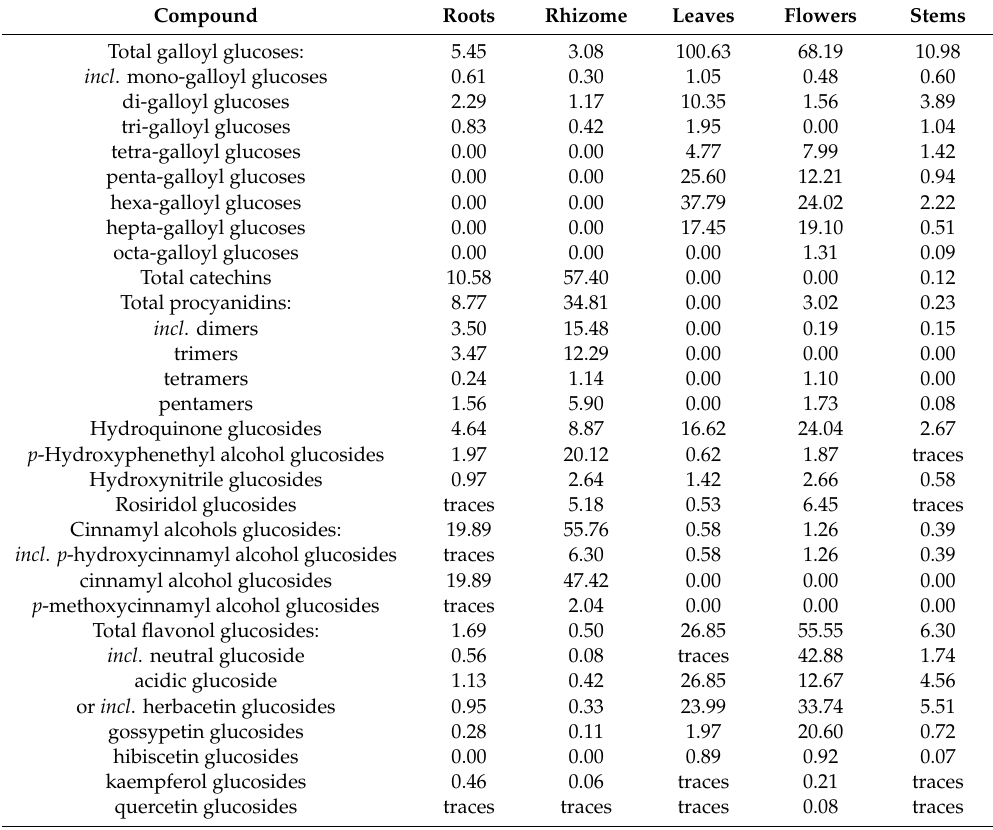
Table 6. Quantitative content of compounds found in R. rosea organs, mg / g dry plant weight. Compound Roots Rhizome